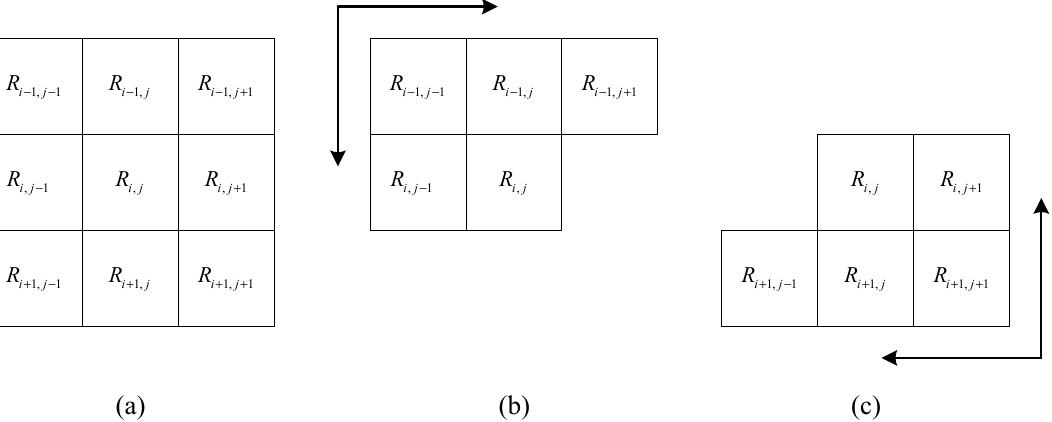
Figure 8. Scan process in the map algebra-distance transformation with obstacles (MA-DTO) algorithm. ( a ) Eight neighbors of target cell R i , j ; ( b ) the scanning order from top to bottom; and ( c ) the scanning order from bottom to